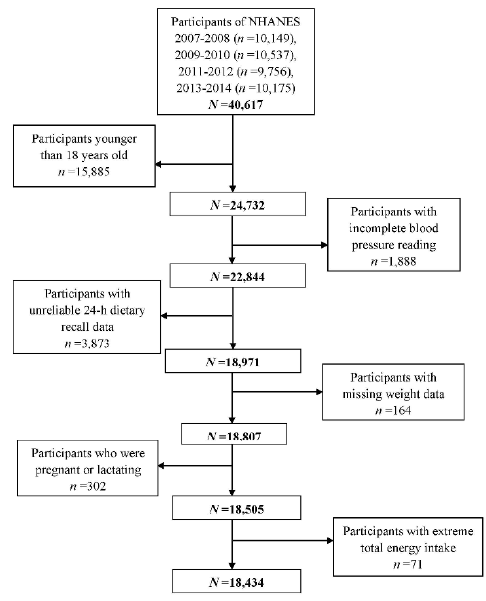
Figure 1. Flow chart of the screening process for the selection of eligible participants.